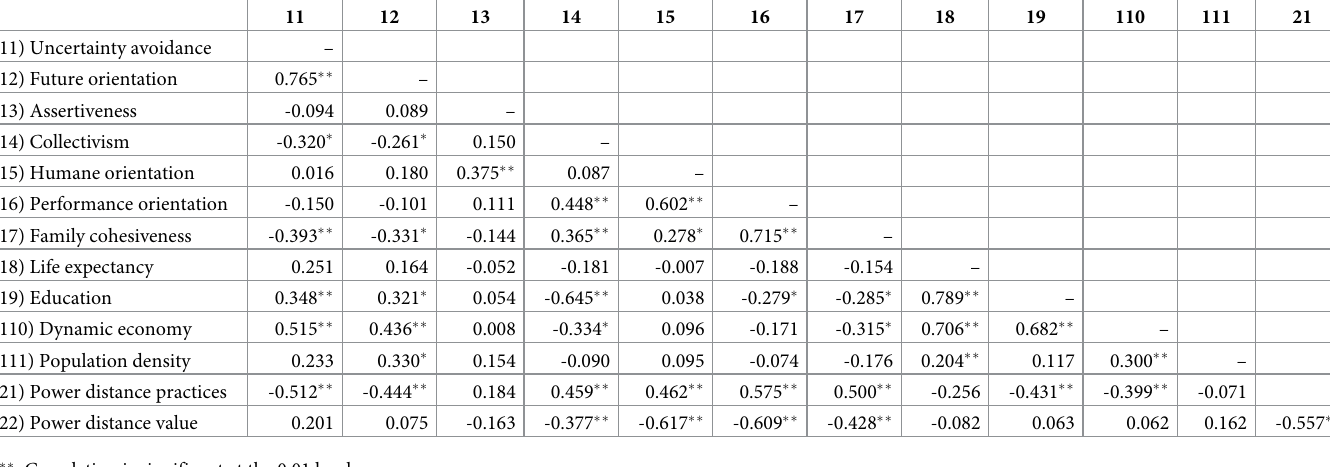
Table 2. Correlation